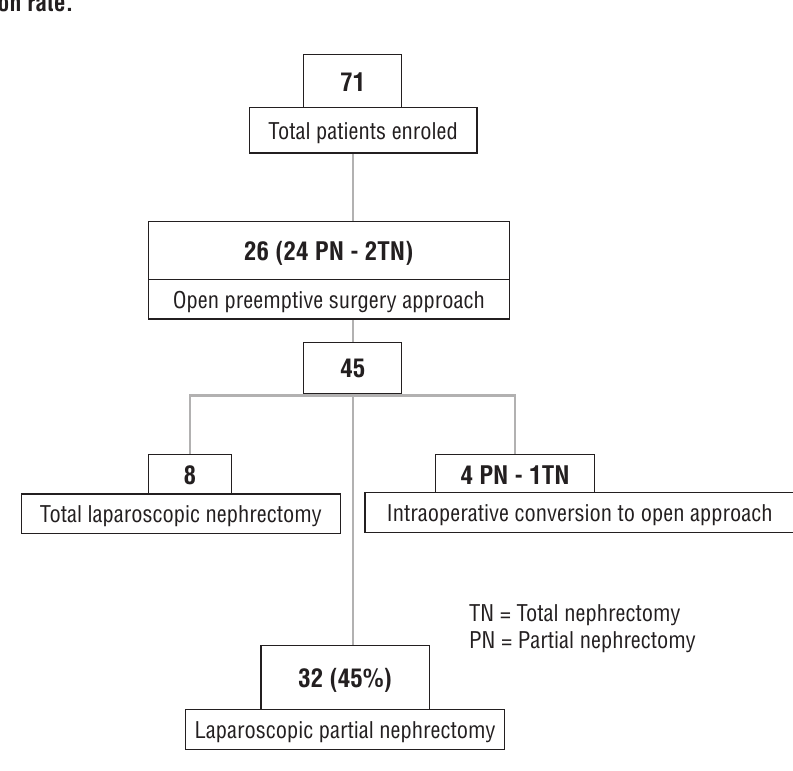
figure 1 - conversion rate.